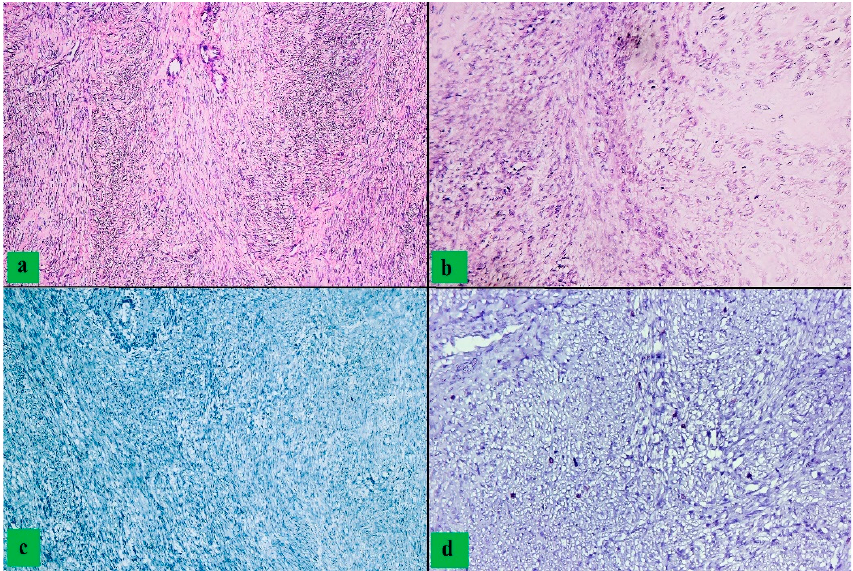
Figure 2. STUMP: ( a , b ) proliferation of smooth muscle fibers with increased density and moderate nuclear atypia (HE, ob 200×); ( c ) absence of p53 immunohistochemical expression (ob 200×); ( d ) CD8 positive T cells (ob 200×).